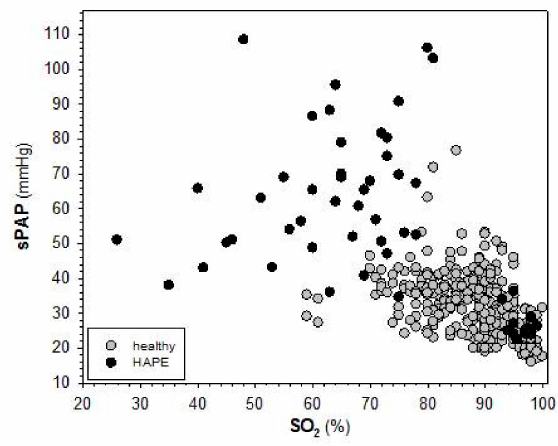
Figure 2. Lack of correlation between systolic pulmonary arterial pressure (sPAP) and SO 2 in HAPE. Individual values from published studies [2,12,40,41], which had all been performed at the Capanna Margherita (4559 m), where subjects ascended by cable car to an altitude of 3200 m and climbed then to the Capanna Gnifetti (3600 m) in the afternoon and spent the night at this altitude. On the next morning they climbed to the Capanna Margherita (4559 m), where they spent two